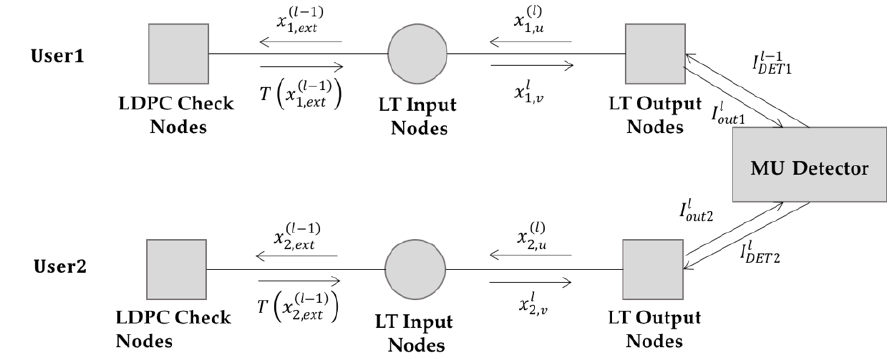
Figure 4. Extrinsic information (EI) transfer on the decoding graph during the decoding iteration. For the l th iteration of the first stage decoding, firstly EI is exchanged on the Raptor decoding graph of user 1, i.e., on the upper part of Figure 3: